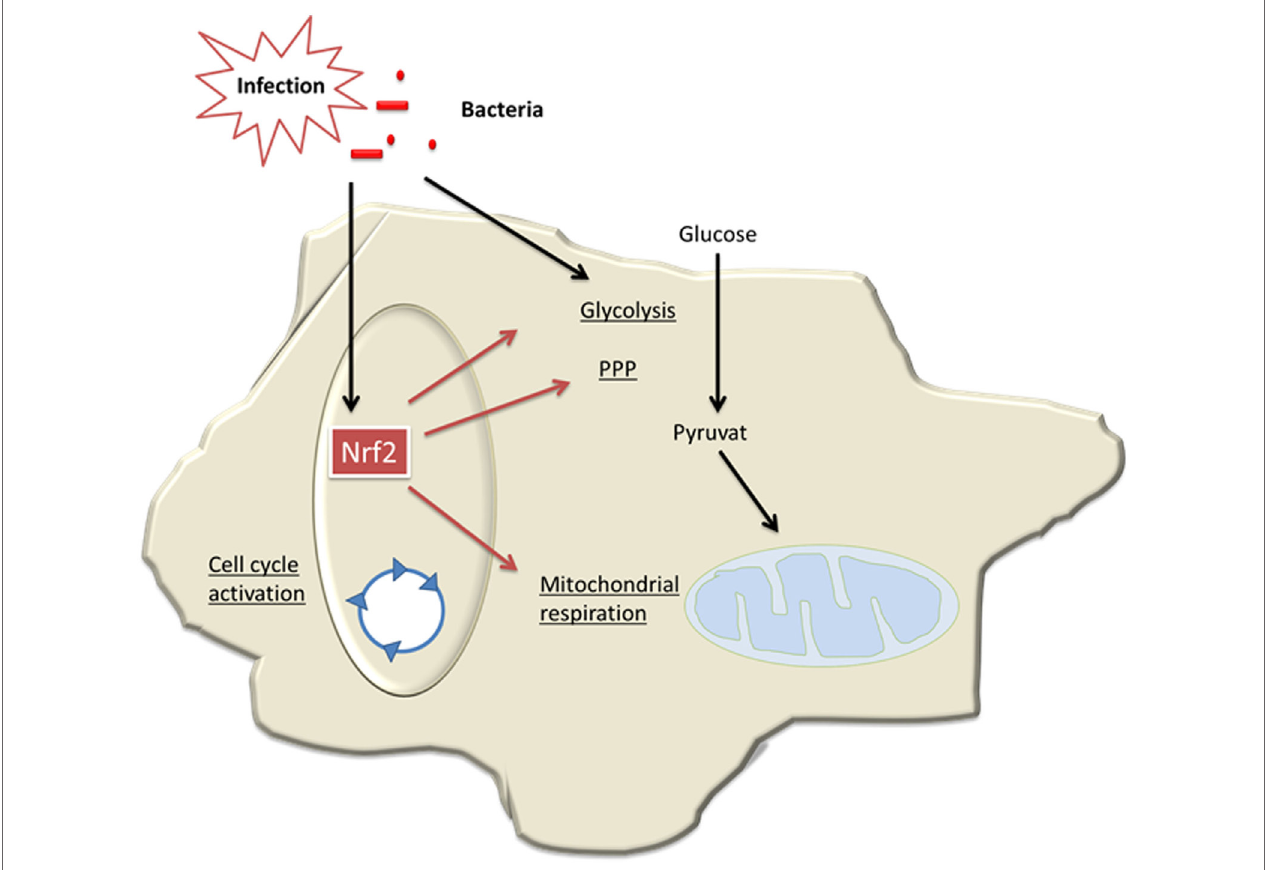
FigUre 8 | Model of Nrf2-mediated roles in myeloid-derived suppressor cells (MDSCs) in sepsis. During infection and sepsis, Nrf2 is activated by reactive oxygen species (ROS) molecules or TLR pathways. Nrf2 induces cell cycle activation and enhances metabolic activity and thereby contributes to expansion of MDSCs in